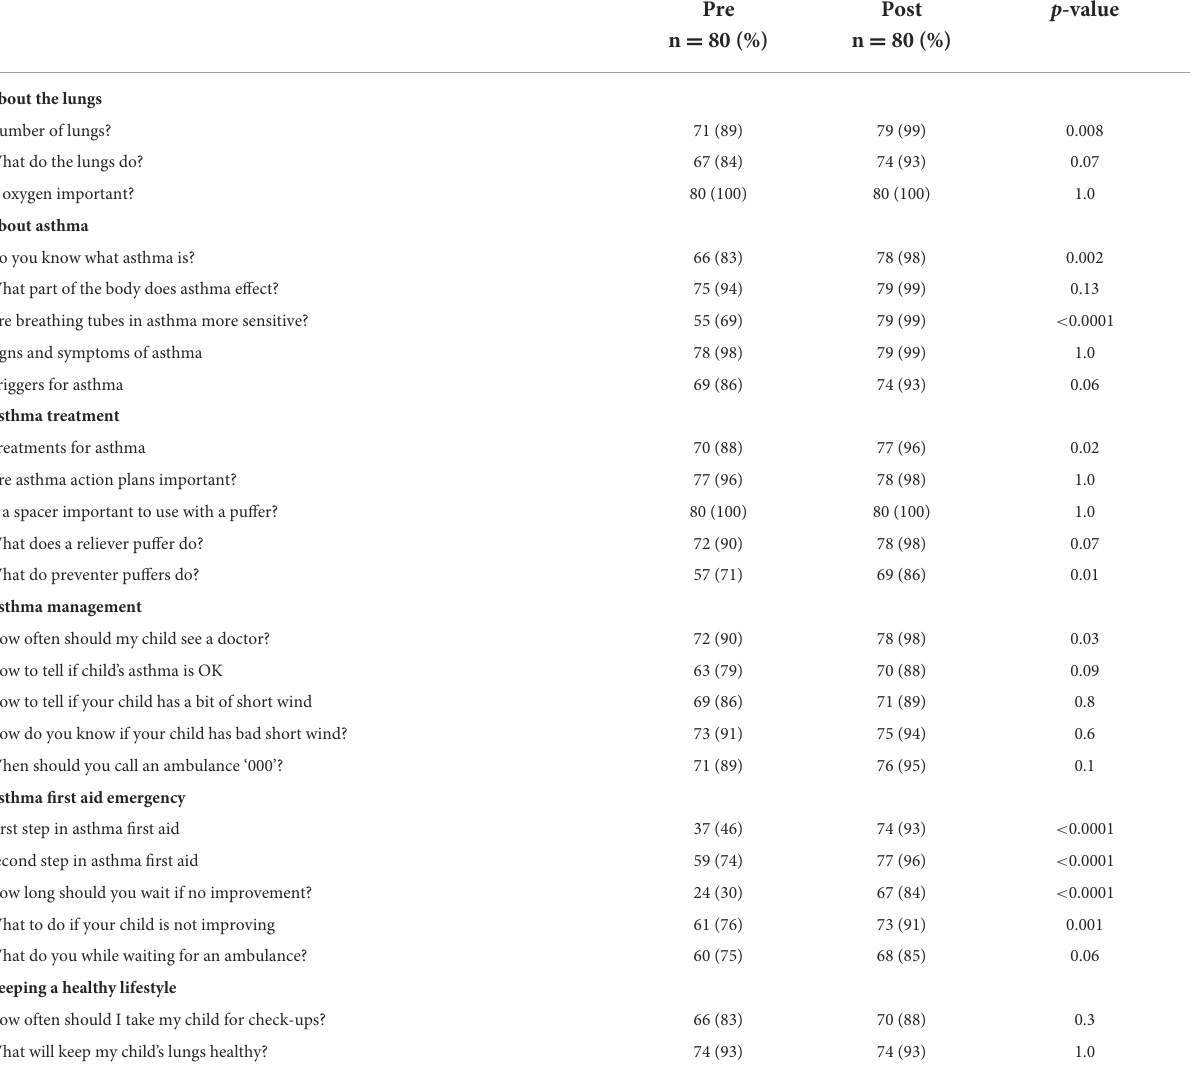
TABLE 2 Comparison of pre- and post-questionnaire scores from carers. Questions by